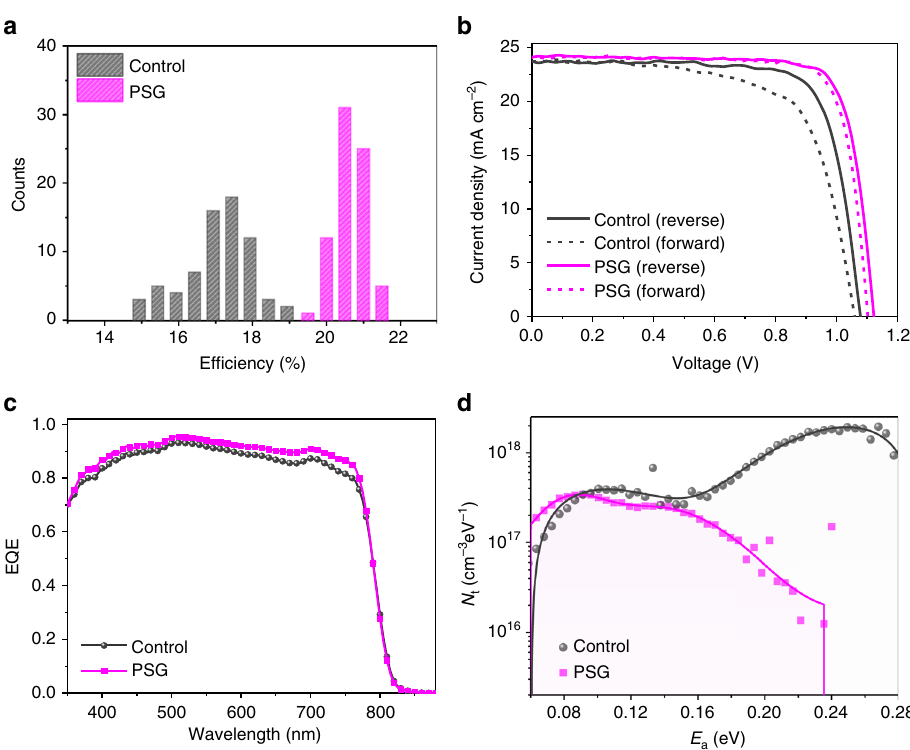
Fig. 5 Photovoltaic performance of control and PSG perovskite solar cells. a Histogram of solar cell ef fi ciencies for control and PSG devices. b J - V curves of the best-performing control and PSG devices with a scanning rate of 10 mV s − 1 (voltage step of 10 mV and delay time of 1000 ms) from 1.15 to − 0.01 V as the reverse scan, and from − 0.01 to 1.15 V as the forward scan. c The external quantum ef fi ciency (EQE) spectra of the control and PSG devices. d